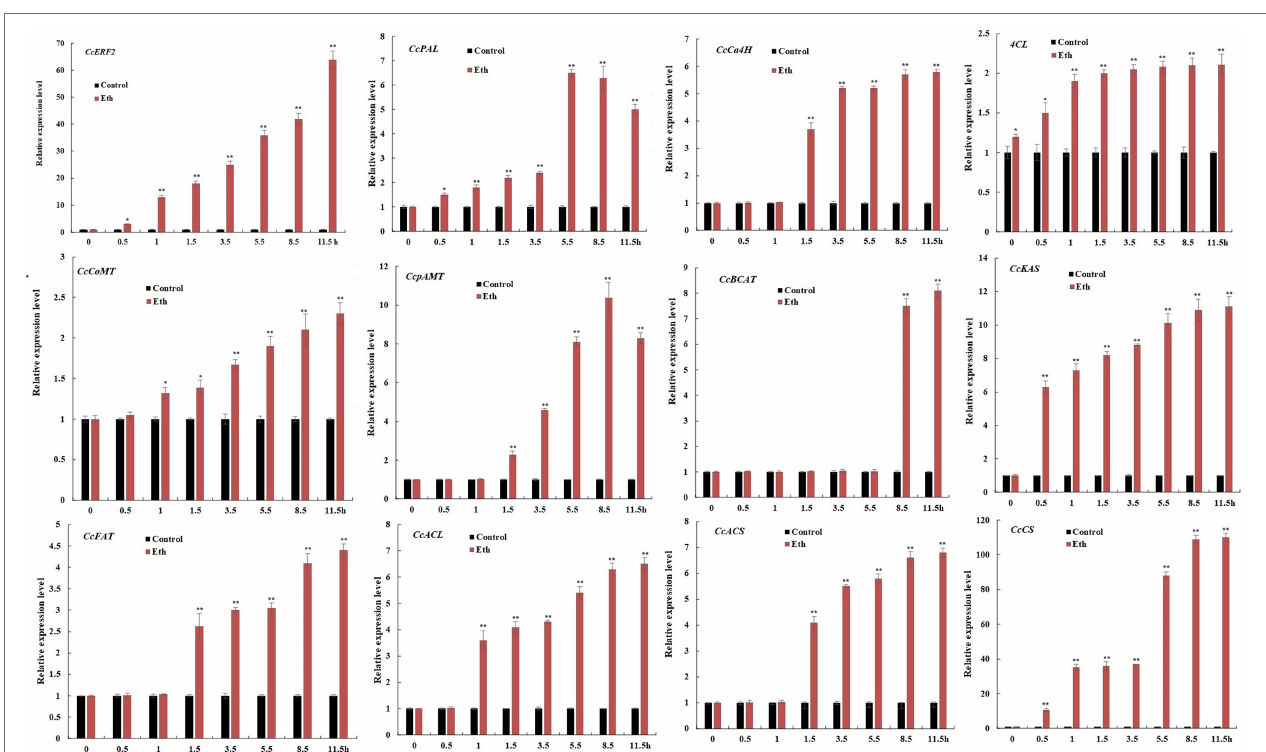
FIGURE 6 | Expression profiles of CBGs after treatment with Eth. The 24 DAP pepper fruits were treated with Eth, and the fruit were sampled after elicitation for 0.5, 1.0, 1.5, 3.5, 5.5, 8.5, and 11.5 h. Without induction at the 0 h time point was used as control expression. The experiments were replicated three biological times and three technical times. Data are expressed as the mean ± SD ( n = 9). Student’s t -test was used to identify significant differences compared to the control (* p < 0.05, ** p <